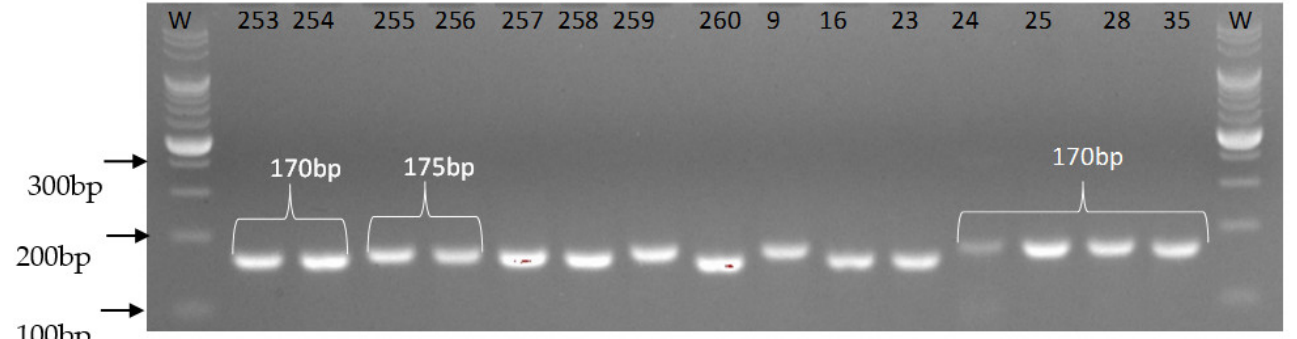
Figure 1. Electrophoretic image of PCR products in 2% agarose gel using bnlg1621 primer pair.